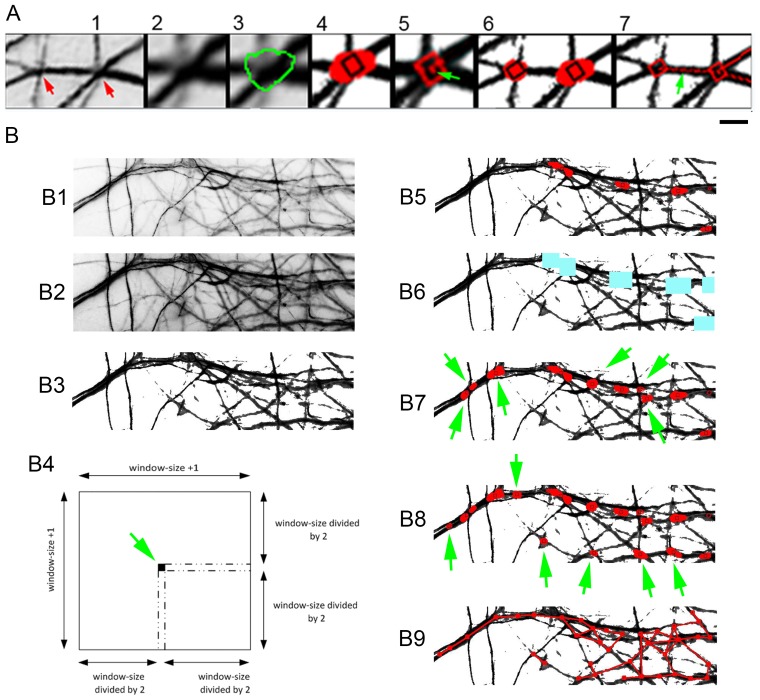
CCM procedure for generating connectivity maps.(A) Basic principles of identification of dendritic branch intersections and their connections. Dendritic intersections (A1) are identified based on their greater width compared to the dendritic segments composing them (A2, labeled in A3). The intersections are marked (A4), centralized (arrow in A5) and connected by a line (A6, arrow in A7). (B) General description of CCM operation. (B1) Starting image – grayscale, inverted. (B2) Contrast optimization. (B3) Background whitening. (B4) A scanning box with centralized pixel (arrow). (B5) Identified junction area (red) with estimated “intersection center pixels” (black squires). (B6) Areas at and near intersections are removed (colored in blue). (B7) second iteration on an updated image (using varying threshold for intersections) reveals thinner intersections (arrows). (B8) A third iteration generated after removal of the B7 new intersections and using a new threshold revealed additional and even thinner intersections (arrows). (B9) Generation of lines connecting the intersections, according to the neuritic map. Scale: A - 3.5 µm; B - 12 µm.